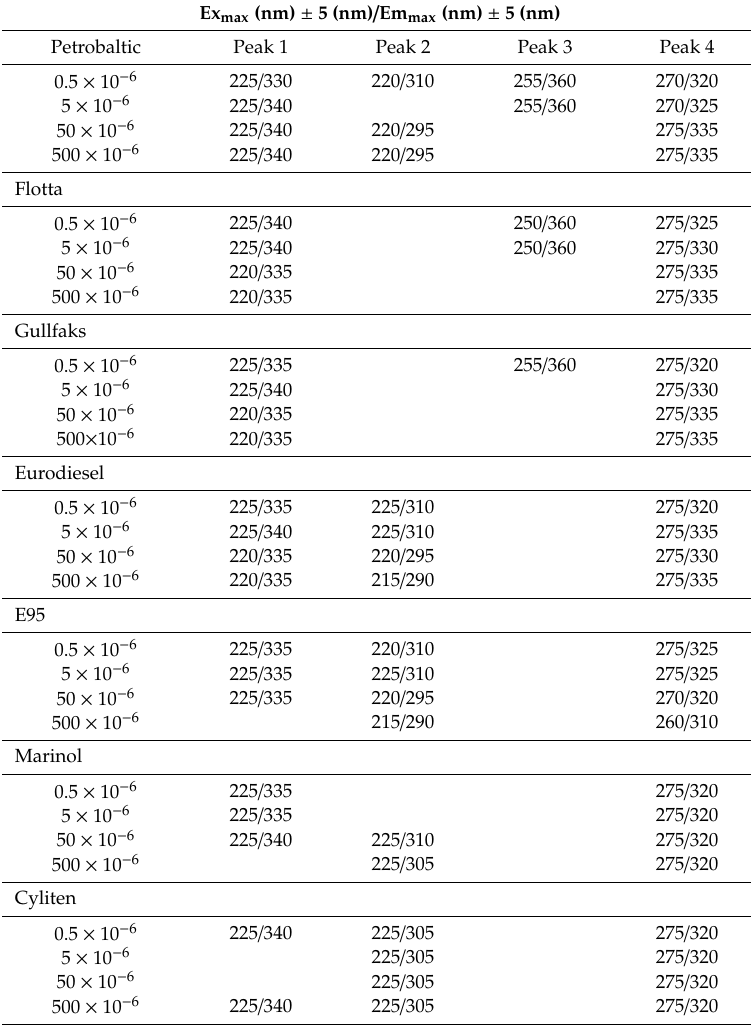
Table 1. Major fluorescent peaks of natural seawater and the same samples polluted by oil at oil-to-water ratios of 0.5 × 10 − 6 , 5 × 10 − 6 , 50 × 10 − 6 , and 500 × 10 − 6 with their wavelength-independent maxima (for 15 March